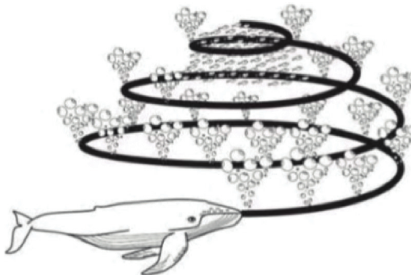
Figure 1: [26] Schematic diagram of whale bubble-net